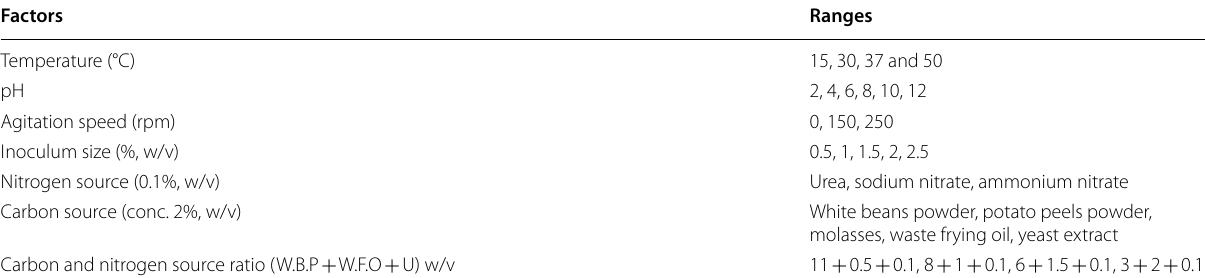
Table 1 Optimization of low-cost substrate and culture conditions for lipopeptide production by Bacillus subtilis SNW3